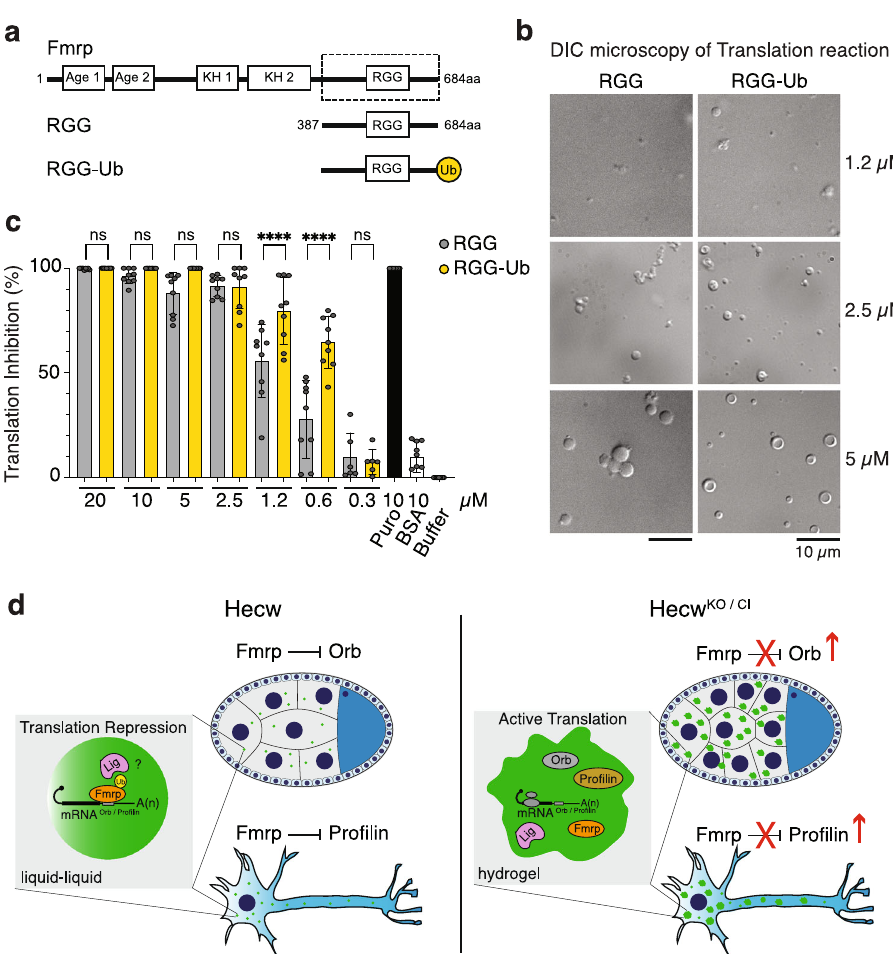
Fig. 9 Ubiquitin increases Fmrp phase-separation propensity and translational repression. a Schematic representation of the generated constructs: Fmrp 837-684 (RGG) and Fmrp 837-684 -Ub fusion (RGG-Ub). b DIC microscopy images of droplets formed at the indicated protein concentration in the translation reaction mixture. Representative images of three independent experimental replicates. Scale bar: 10 µ m. c Titration of RGG or RGG-Ub into the luciferase translation reaction inhibits translation. Translation of luciferase mRNA was measured by percentage decrease in luminescence in the presence of RGG (light grey), RGG-Ub (yellow), Puromycin (black), and BSA (white) with respect to Buffer. Results are plotted as mean ± SD. **** P < 0.0001 by Ordinary One-Way Anova of three independent experimental replicates. Dots represent individual data points. d Proposed model of RNP regulation by Hecw. In normal conditions, both in ovary and in neurons, Hecw ubiquitinates Fmrp and contributes to the maintenance of its translational repression activity, possibly through the interaction with the Ub receptor Lingerer (indicated with a question mark in the fi gure). In the absence of Hecw, RNPs transition to a less dynamic gel-like state, Fmrp translational repression is lost and Orb mRNA and Pro fi lin mRNA are actively